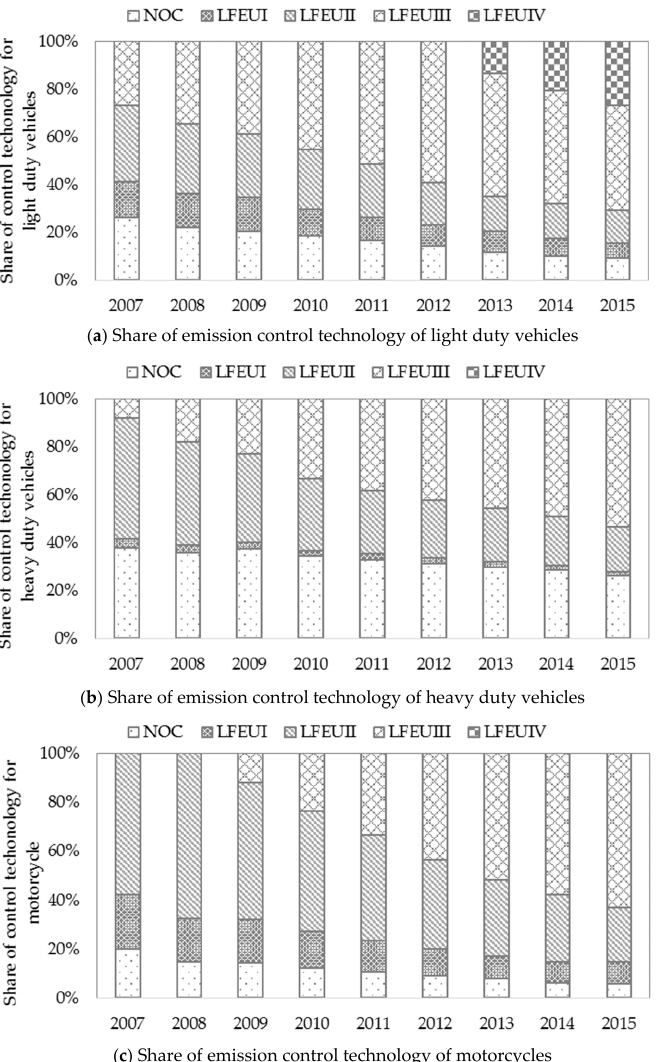
Figure 9. Share of emission control technology by mode in the BMR area from 2007 to 2015: ( a ) light duty vehicles; ( b ) heavy duty vehicles; ( c ) motorcycles.